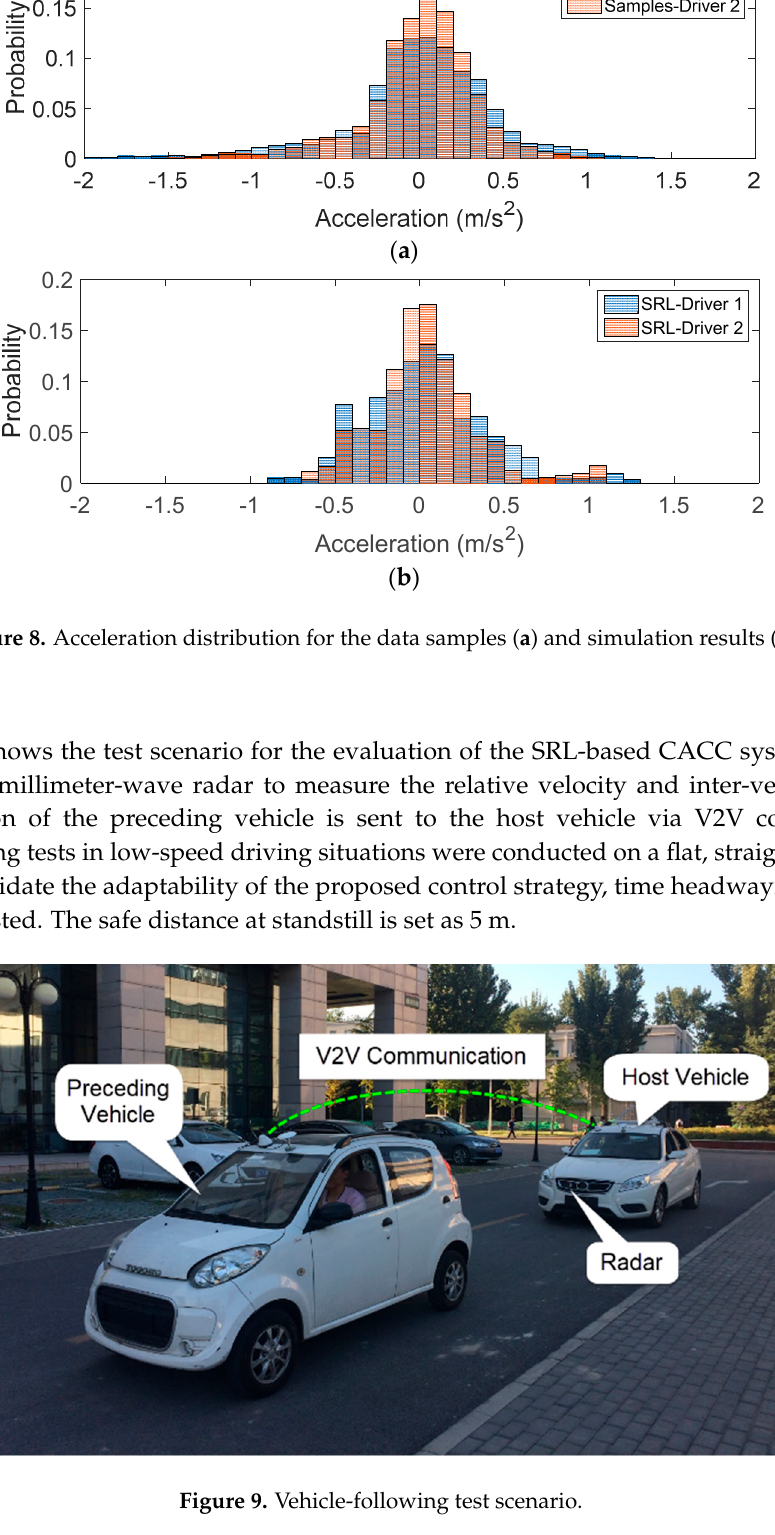
Figure 9. Vehicle-following test scenario.